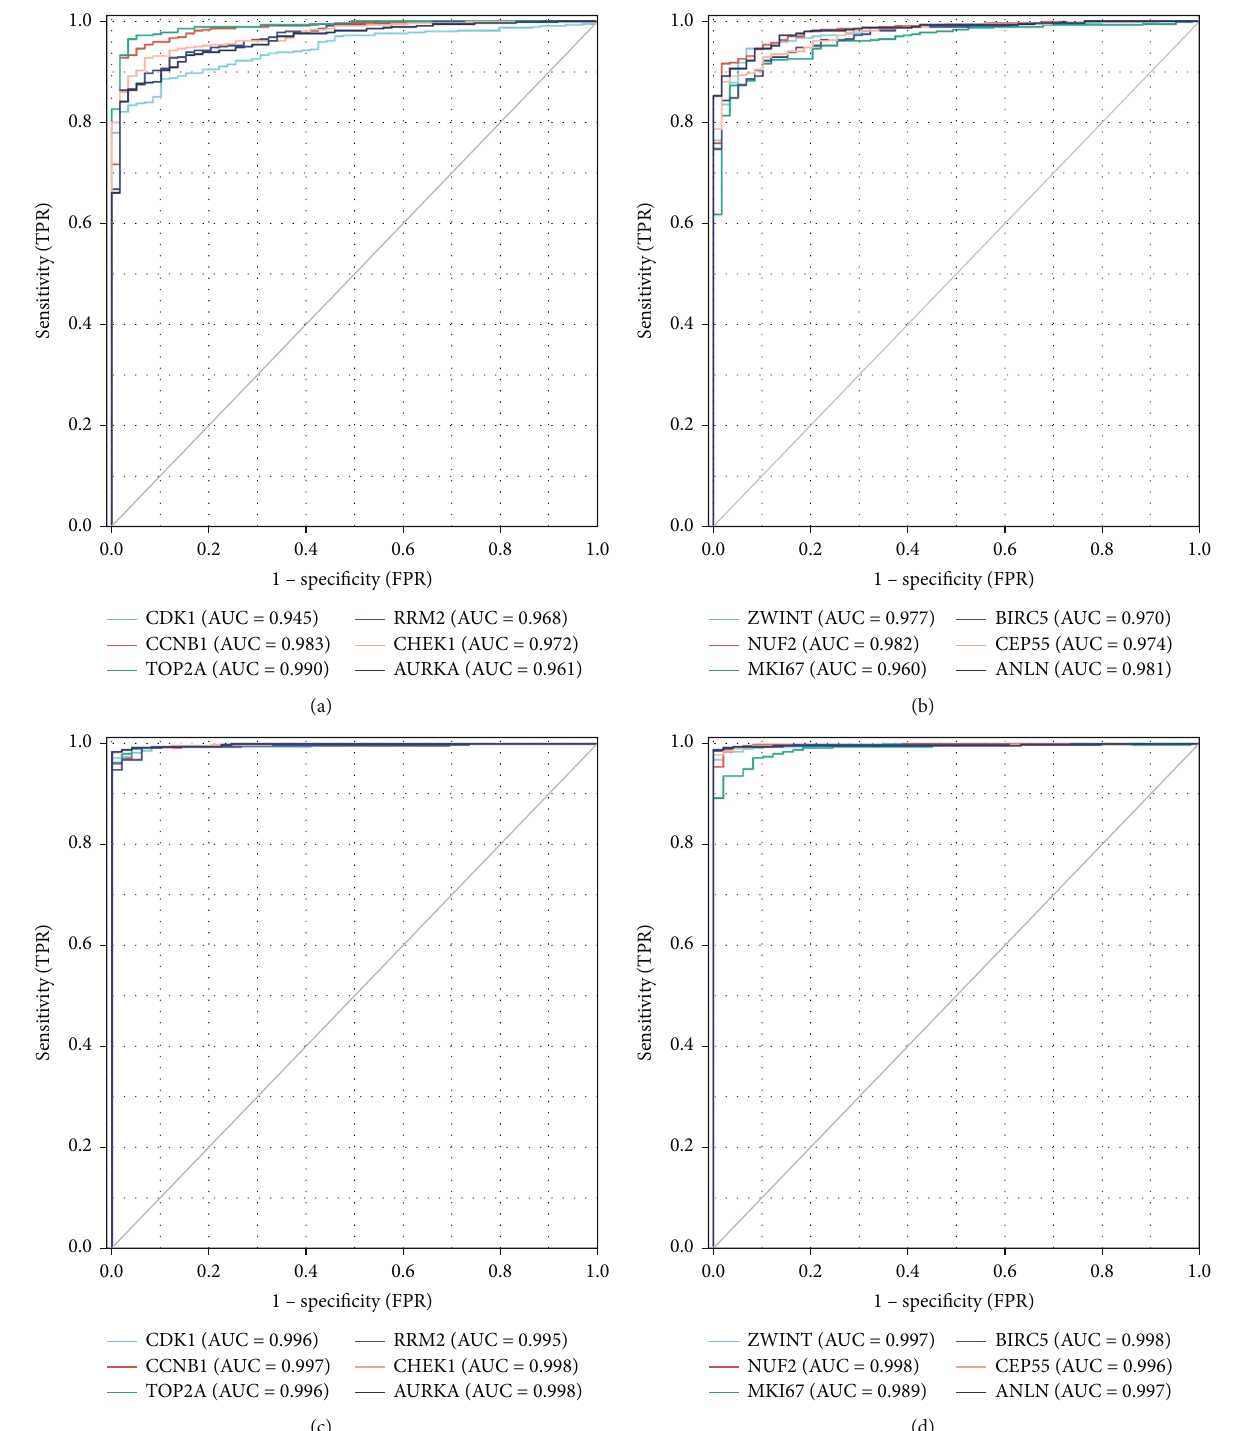
Figure 4: The 12 hub genes were analyzed with the pROC package in R language and visualized with the ggplot2 package. (a) and (b) are receiver operating characteristic curves (ROC) of LUAD, and (c) and (d) are receiver operating characteristic curves (ROC) of